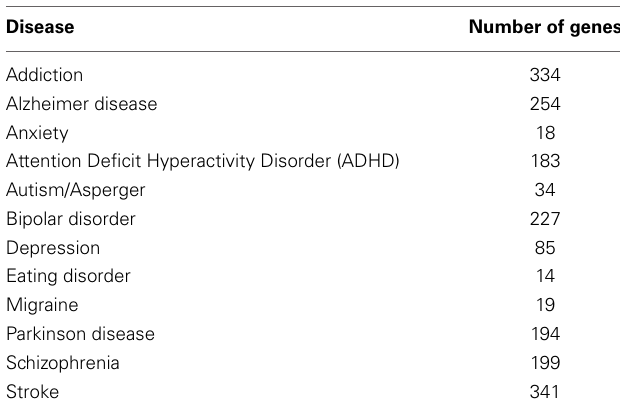
Table 1 | Number of genes from Genetic Association Database by